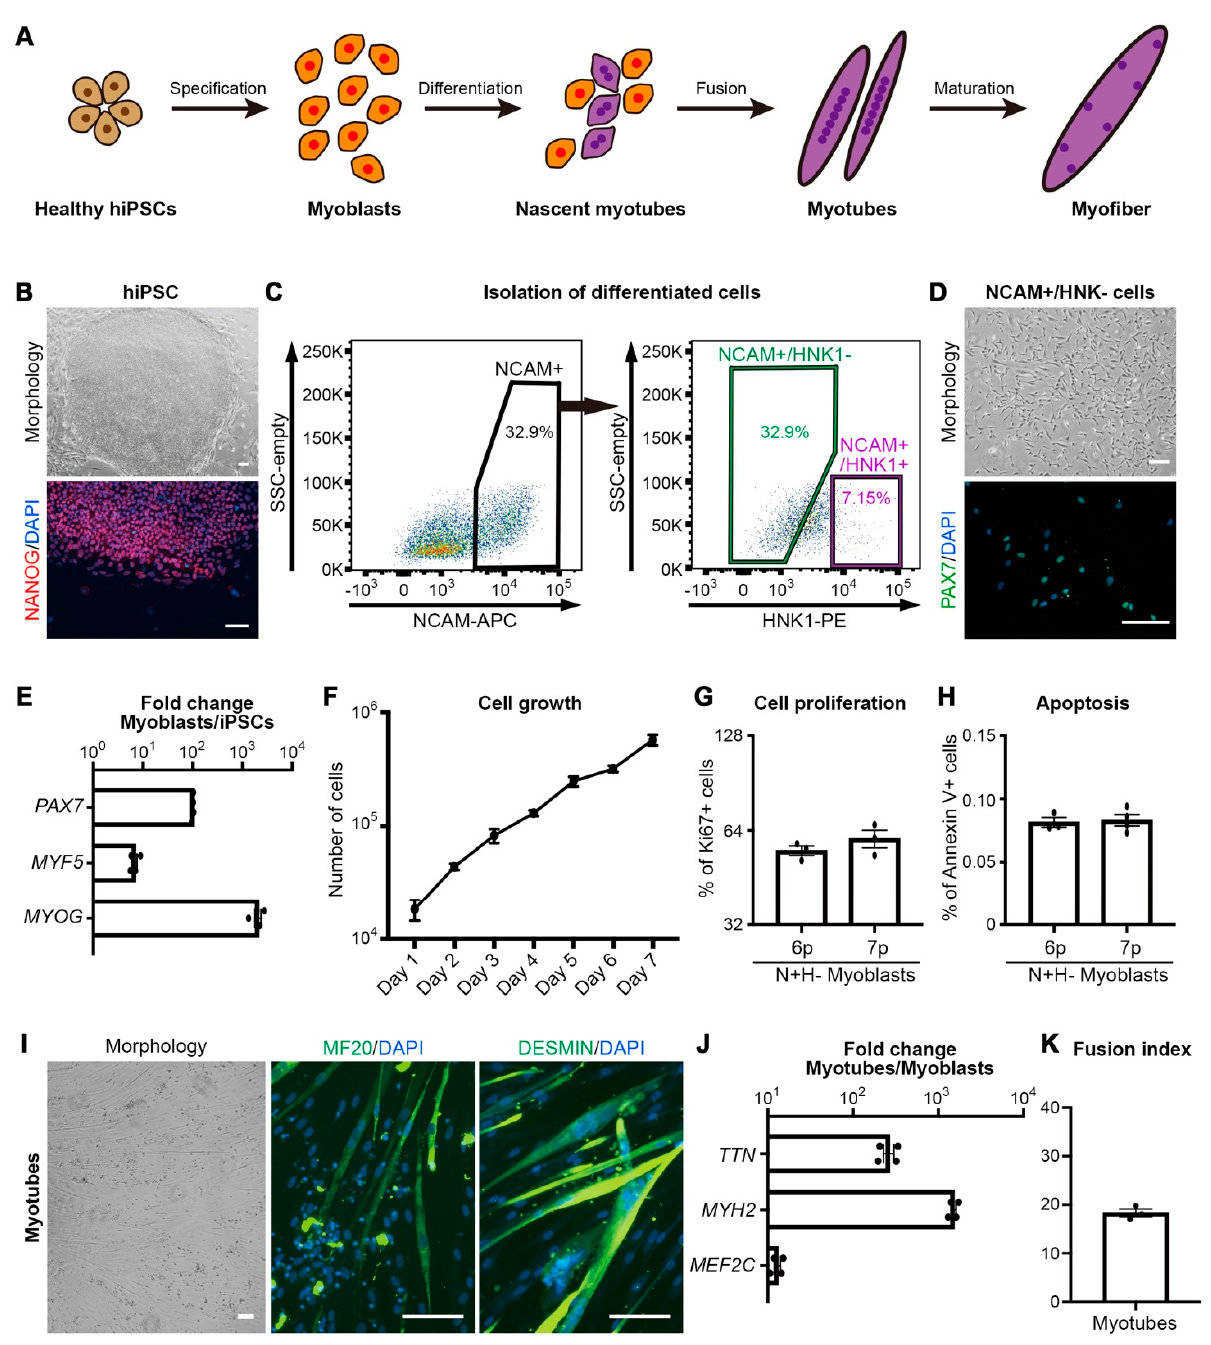
Figure 1. In vitro screening platform for myotube formation using human pluripotent stem cell-derived myoblasts. ( A ) The schematic illustration of the embryonic myogenesis of hiPSCs. ( B ) Representative colony morphology of undifferentiated healthy hiPSCs and expression of pluripotency marker NANOG. ( C ) Representative FACS plots for NCAM+/HNK1- cell population. ( D ) Representative image of NCAM+/HNK1- (N+H-) myoblasts and immunohistochemistry of PAX7 in N+H- myoblasts. ( E ) Fold changes of expression levels with myogenic-specific marker genes, PAX7 , MYH5 , and MYOG in the myoblasts/undifferentiated hiPSCs. ( F ) The cell proliferation rate of N+H- myoblasts after sorting. ( G ) The percentage of Ki67+ cells in the N+H- population. ( H ) The percentage of Annexin V+ cells in the N+H- population. ( I ) Representative image of myotube from expanded myoblasts (hiPSC-derived). And myotube formation ability of N+H- cells con- firmed by MF20 and DESMIN expression. ( J ) Myotube-related gene expression levels in the myotube/myoblasts. ( K ) The fusion index of the myotube which calculated as a ratio of the number of nuclei inside myotubes to the number of total nuclei x 100 after myotube formation. Scale bars = 100 um.